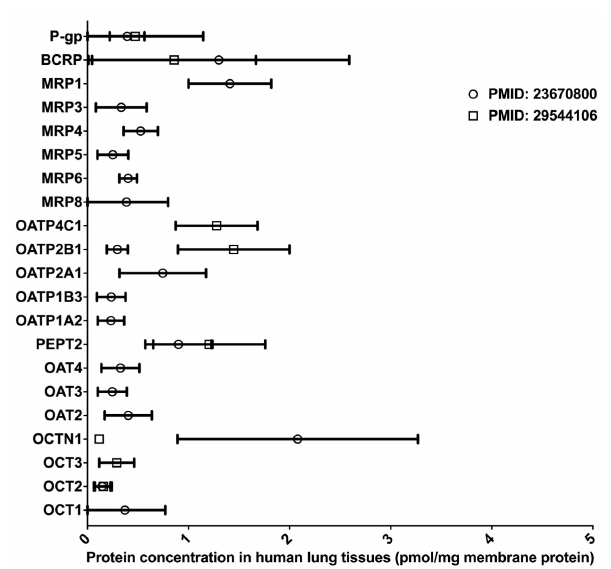
Figure 4. Absolute quantification of major clinically relevant transporter proteins in human lungs. Protein expressions are presented as means with standard deviations. BCRP, breast cancer resistance protein; P-glycoprotein; MRP,multidrugresistance-associatedprotein; OATP,organicaniontransporting polypeptide; PEPT, peptide transporter; OAT, organic anion transporter; OCTN, organic cation / carnitine transporter; OCT, organic cation